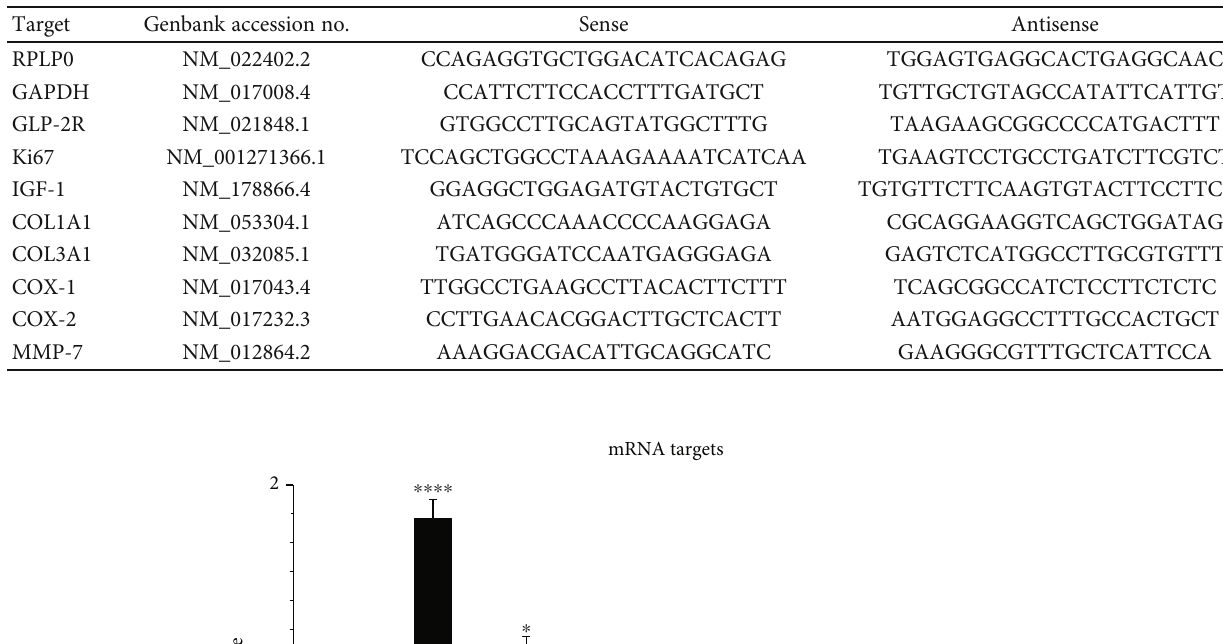
Table 1: Overview over primer sequences for mRNA analyses by RT-qPCR.